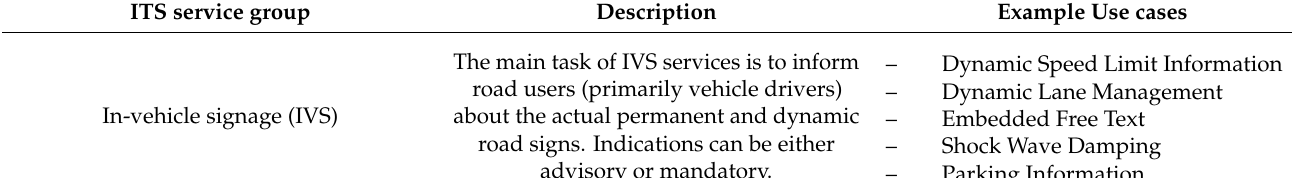
Table 2. Relevant ITS service groups and use